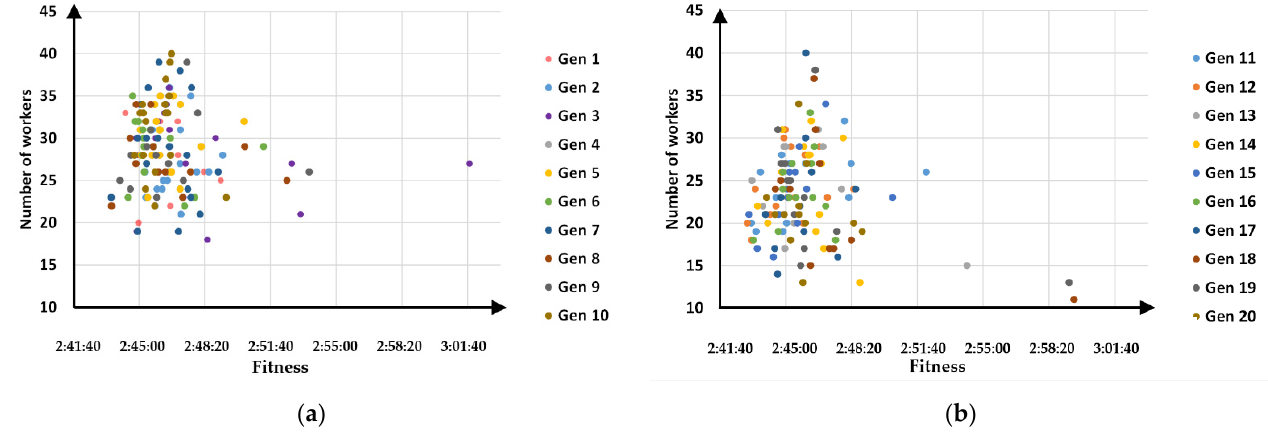
Figure 11. Graph showing all fitness values for each generation: ( a ) for generation 1 to 10; ( b ) for generation 11 to 20.